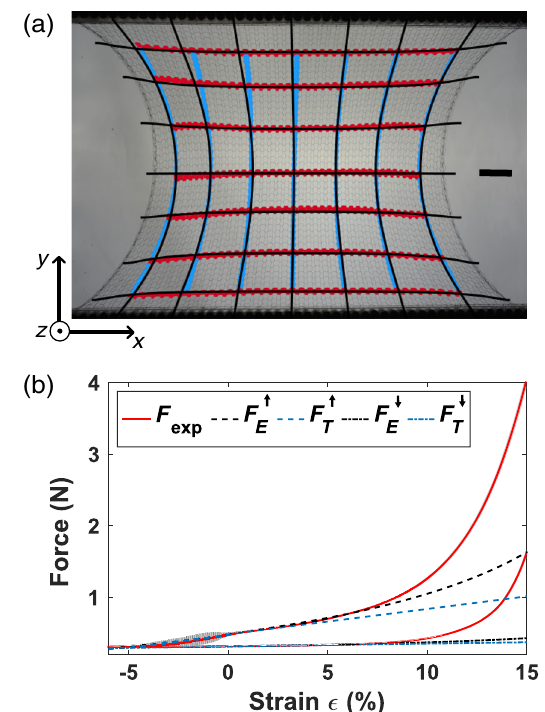
FIG. 7. Predicted and experimental deformations of a stretched fabric in the y -direction and its mechanical response. (a) The measured displacement field ⃗ u ð x; y Þ is displayed along 7 course (red line) and 7 wale (blue line) directions, while the black curves (black line) are their corresponding predictions without adjustable parameters. The applied strain in the picture is ε ¼ 11% and the scale bar in the panels indicates 2 cm. (b) Red curves reproduce the experimental results of Fig. 1(b). The grey area represents 2 times the standard deviation of the force signals over the 5 cycles. The forces F E (dashed line) and F T (dot and dashed line) are calculated respectively from the variation of bending energy and the Lagrange multiplier T ð x Þ (see Appendix